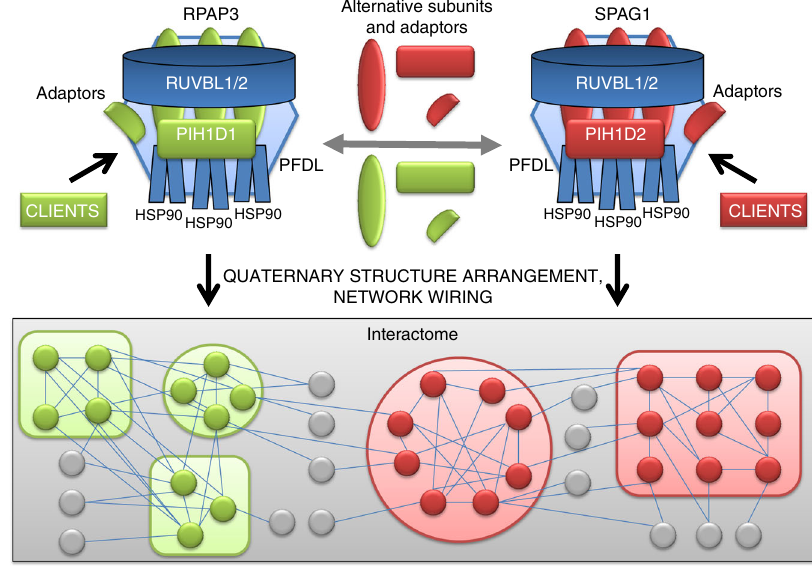
Fig. 1 Representation of putative alternative PAQosomes. The PAQosome (originally R2TP/PFDL complex) exists in different fl avors generated through the differential integration of homologous subunits (e.g., RPAP3 vs. SPAG1, PIH1D1 vs. PIH1D2, etc). The results of Martino et al. 9 suggest that up to three RPAP3 may bind the RUVBL1-RUVBL2 scaffold, although this has not been con fi rmed in vivo. The existence of alternative PAQosomes along with the use of various speci fi city factors (adaptors) can theoretically multiply by many fold the number of clients they can act upon during quaternary structure arrangement, playing a central role in building up the interactome (protein complexes and networks). Whether alternative subunits modify the overall organization and composition of the PAQosome remains to be addressed